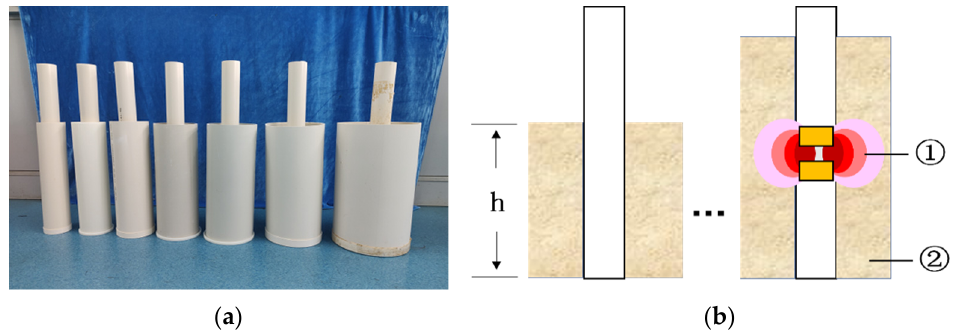
Figure 15. Sensor detection range test. ( a ) Soil samples of di ff erent radii to be tested; ( b ) soil samples at di ff erent heights to be measured. ① Probe; ② soil.